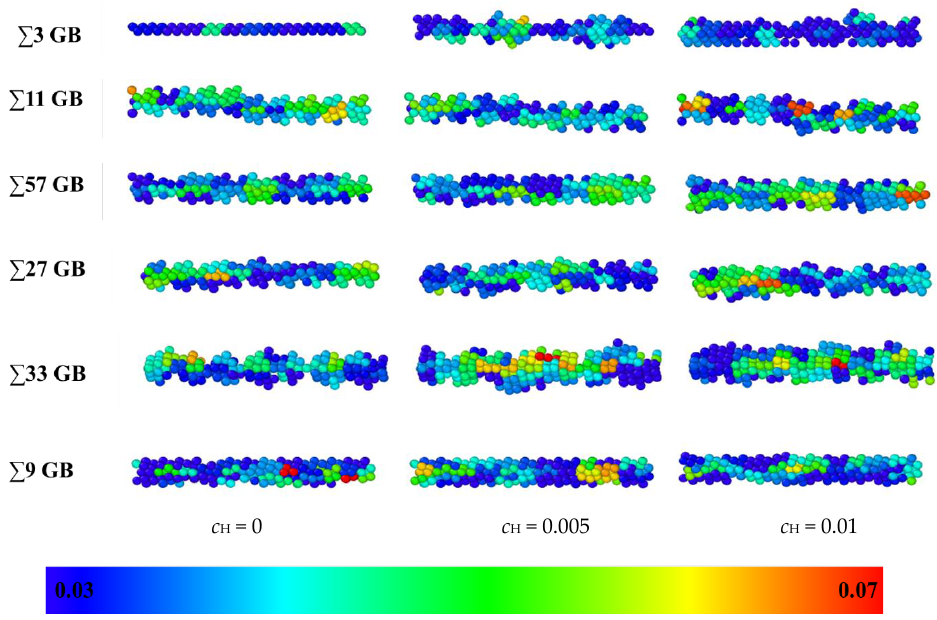
Figure 7. A comparison of the excess volume of different GBs at different hydrogen concentrations: 0, 0.005, and 0.01 atomic ratios. Blue indicates an MSD value of 0.03 Å 2 , and red indicates an MSD value of 0.07 Å 2 .